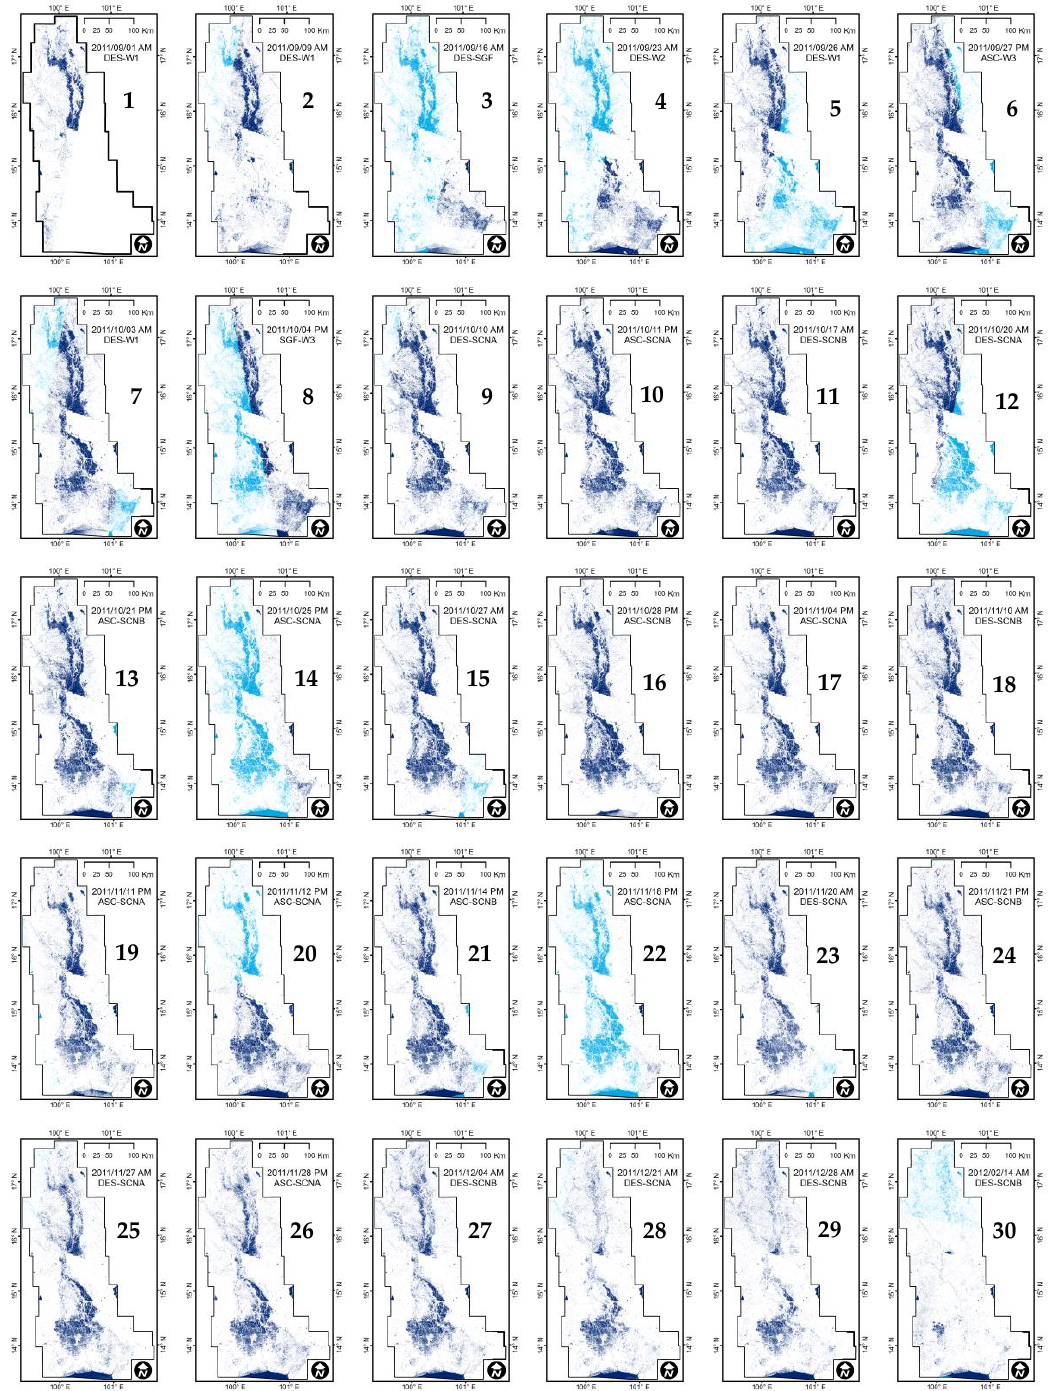
Figure 6. Extracted water areas after applying the global threshold value for each Radarsat-2 image. The extracted results from the actual date are shown in deep blue, and the results from the previous date are shown in light blue.